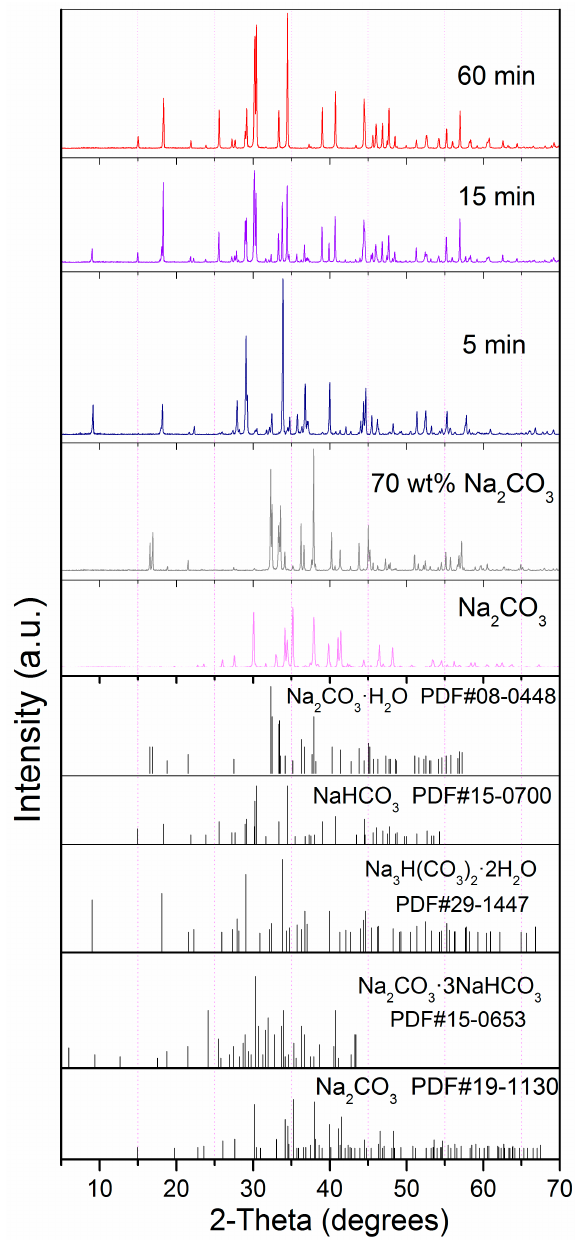
Figure 3. XRD patterns of various Na 2 CO 3 based compounds and the reaction products of HSCP-70 after 0, 5, 15, and 60 min of CO 2 sorption reaction at 30 °C.